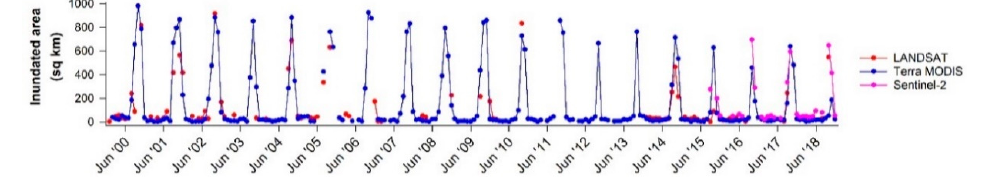
Figure 9. Seasonal variations in water levels observed by different sensors Landsat (red), Terra MODIS (blue) and Sentinel-2 (pink).